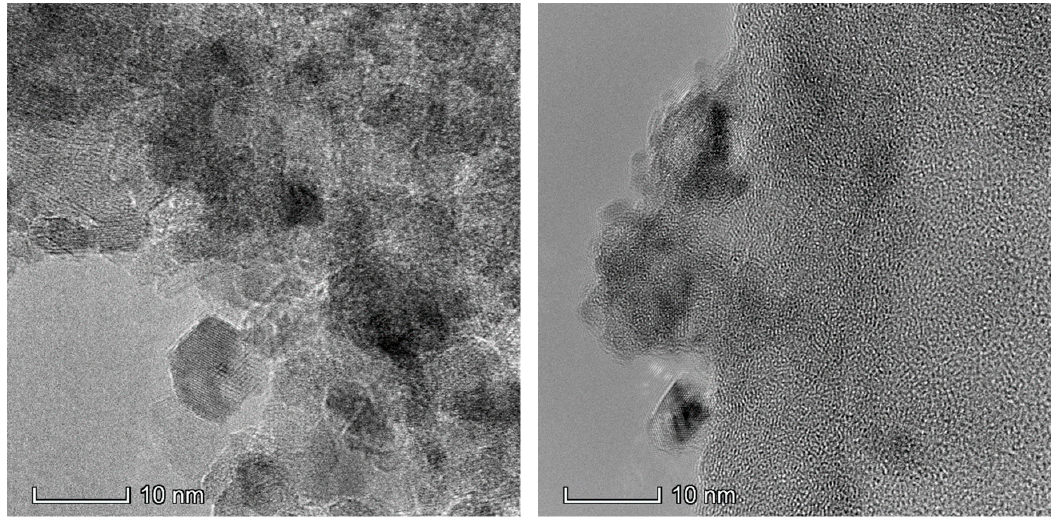
Figure A1. TEM micrographs of 20% Ni/Al 2 O 3 ( left ) and 20% Ni-0.5% Pt/Al 2 O 3 ( right ) showing the similar metal particle size of the monometallic and bimetallic formulations. Catalysts 2018 , 8 , x FOR PEER REVIEW